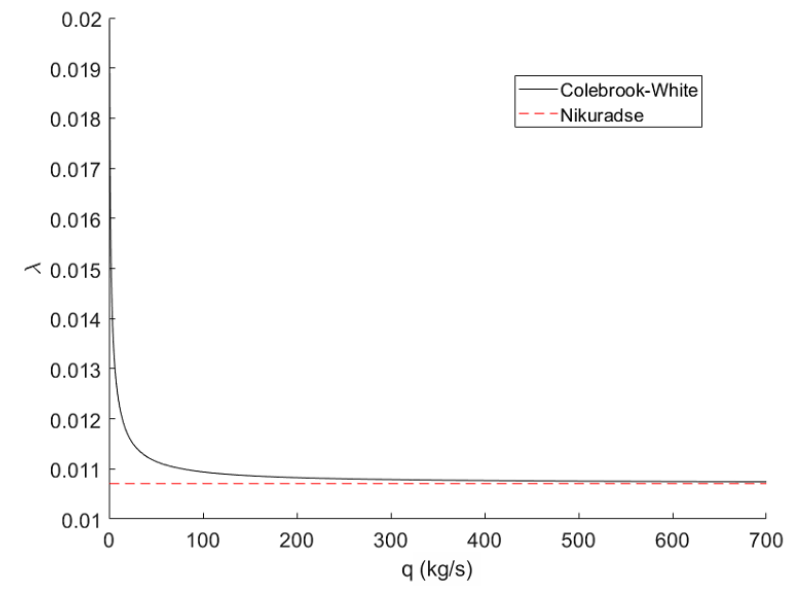
Figure 2. Comparison of the Colebrook–White and Nikuradse friction factor on a pipeline with a diameter of 0.9 m, and roughness of 0.05